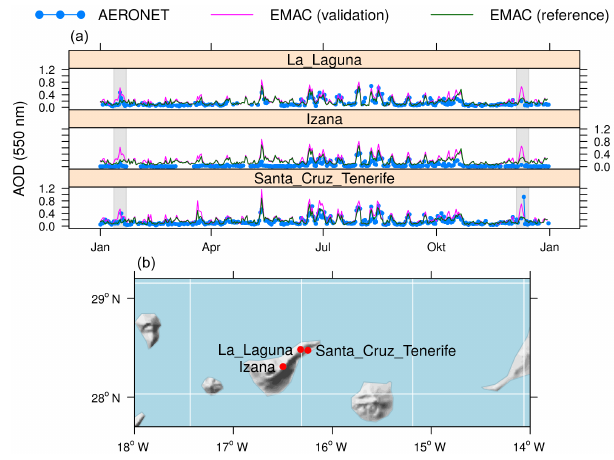
Figure 10. Time series of the daily mean AOD at the Canarian AERONET stations (a) and a map showing the location of the sta- tions (b) . The white squares depict the T106 model grid. During the grey-shaded periods of the time series in January and Decem- ber, at least one of the three AERONET stations observed an AOD peak which is reproduced by the validation but not by the reference simulation.